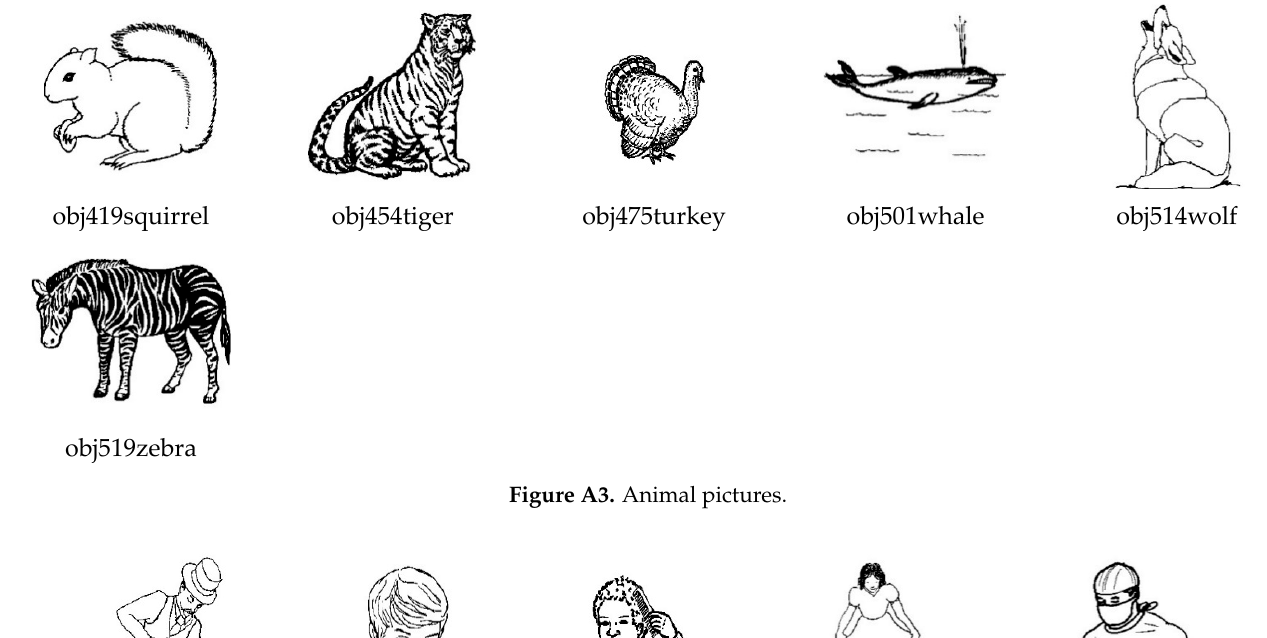
Figure A2. Uncivil pictures. Appendix B obj032bat